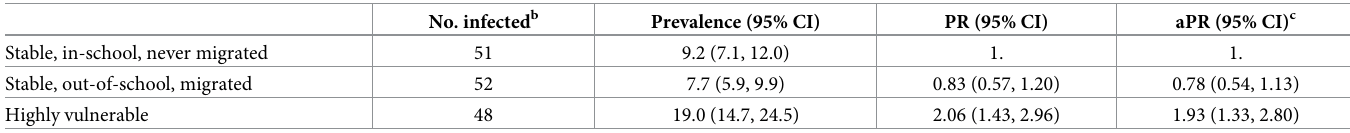
Table 4. Unadjusted and adjusted prevalence ratios (PR) and 95% confidence intervals (CI) for the association between vulnerability profiles and sexually transmit- ted infection (STI) among 1,501 adolescent girls and young women (AGYW) aged 15–24 in Ethiopia, 2018–2019 a